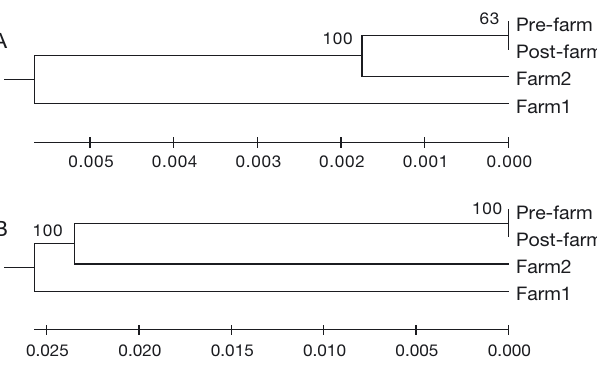
Fig. 4. UPGMA dendrograms based on Nei’s unbiased ge- netic distances between the 4 Atlantic cod samples for (A) allozymes (sum of branch length = 0.0131), and (B) DNA markers excluding Gmo132 , Tch11 and Pan I (sum of branch length = 0.0748). Bootstrap value (%) shown at node